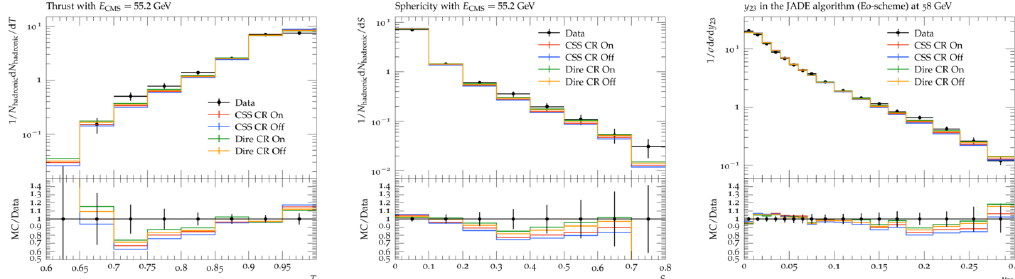
Figure 18: S HERPA results for thrust and sphericity compared with data from A MY [ 78 ] (left and centre), and for the differential 2-jet rate in the J ADE scheme [ 79 ]